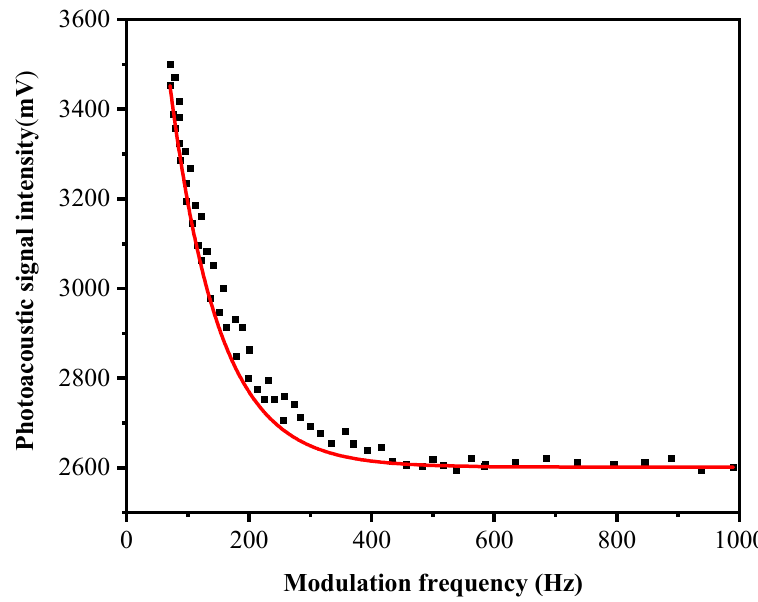
Figure 10. Photoacoustic signals under different modulation frequencies. The third experiment was carried out to measure the concentration of CO 2 in standard gas-liquid solution using the device proposed in this paper. The concentrations of CO 2 in the standard solution were 3.05 mL/L, 6.23 mL/L, 9.16 mL/L, 12.35 mL/L, 16.07 mL/L and 18.66 mL/L. The output frequency of the pulsed laser was 20 Hz, the temperature was 27 ◦ C, and the current was 70 mA. Each of the CO 2 solutions referred to above were measured 120 times, one by one, and on each occasion the measurement was for less than one minute. The solution was kept at room temperature, and the pressure in the photoacoustic cell was standard atmospheric pressure. The measurement results are shown in Figure 11 and the specific data is displayed in Table 1.